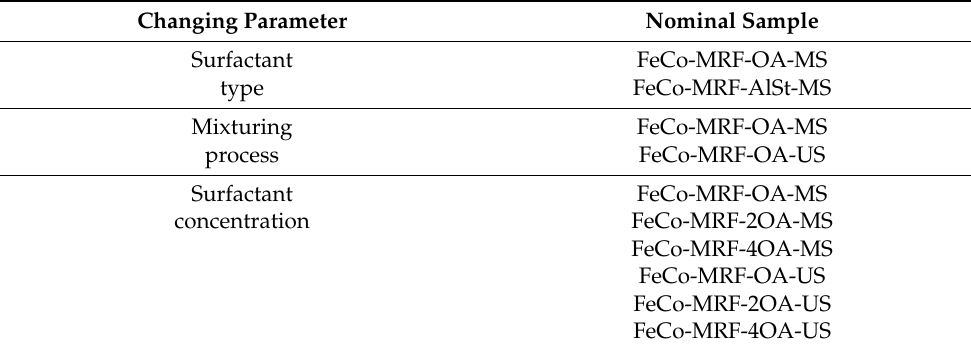
Table 1. Summary of the different magnetorheological fluids analyzed in this